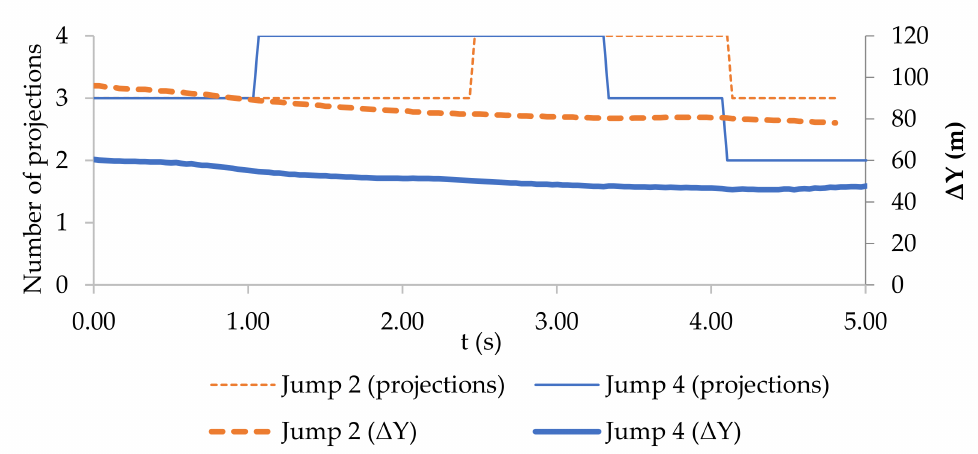
Figure 9. Distance of the moving target from camera 1 during Jumps 2 and 4, and the number of projections of the spherical target during movement in the field of view of the individual